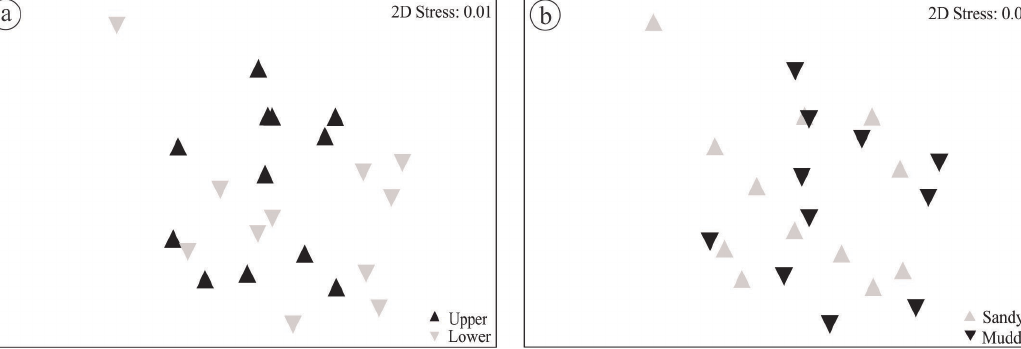
Figure 3. Multidimensional scaling ordination model of abundance of individuals at Tubarão river (Macau, Rio Grande do Norte) in relation to: (a) upper and lower areas of the estuary; and (b) sandy and muddy